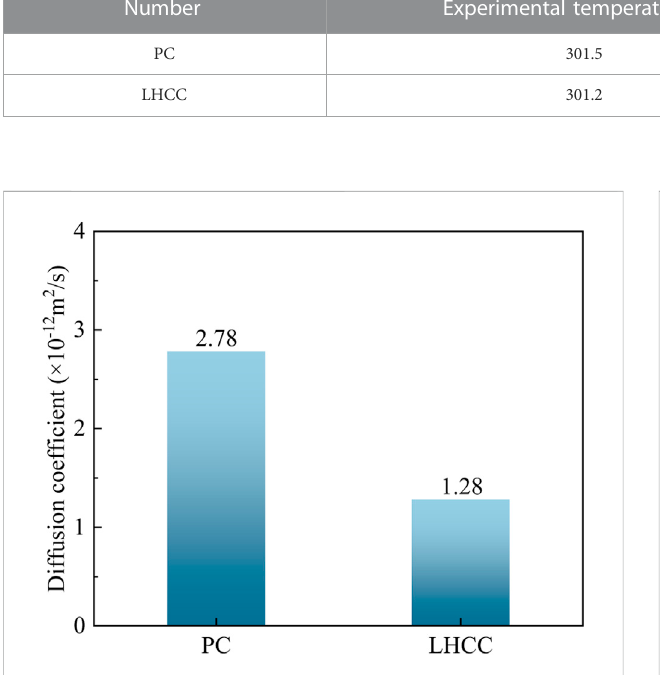
FIGURE 2 Chloride ion permeability coef fi cients of PC and LHCC.